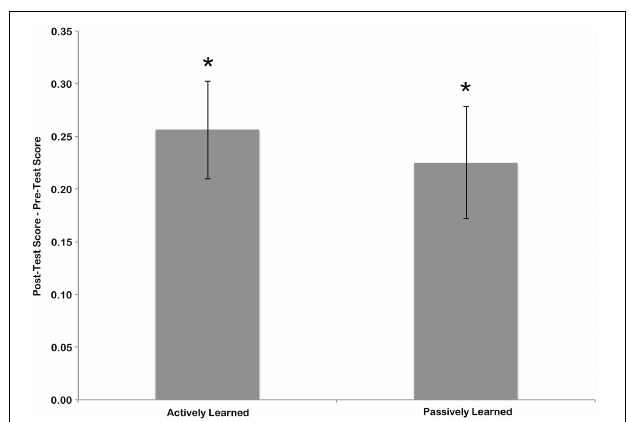
FIGURE 3 | Difference in pre-test and post-test scores for actively and passively learned letters. Error bars are standard error of the mean, and asterisk indicate significant difference from chance (no learning) at p < 0 .